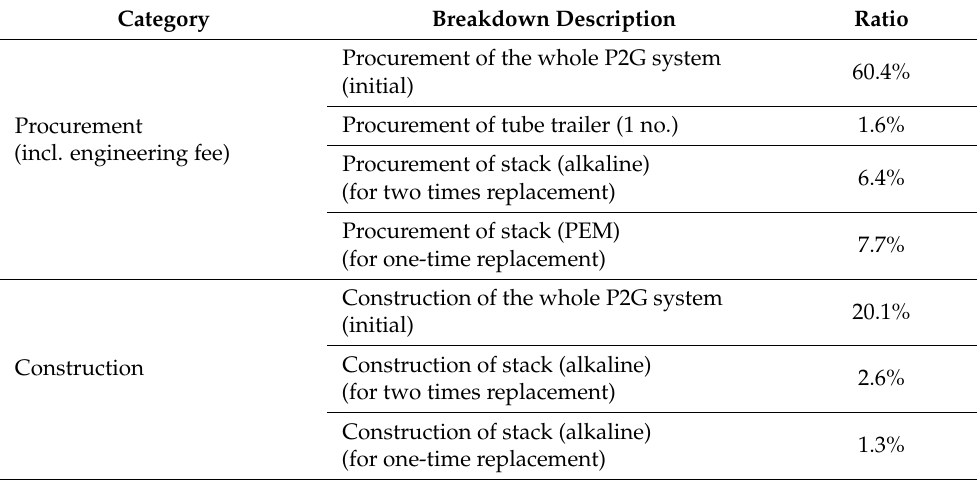
Table 7. Breakdown and ratio of respective items for